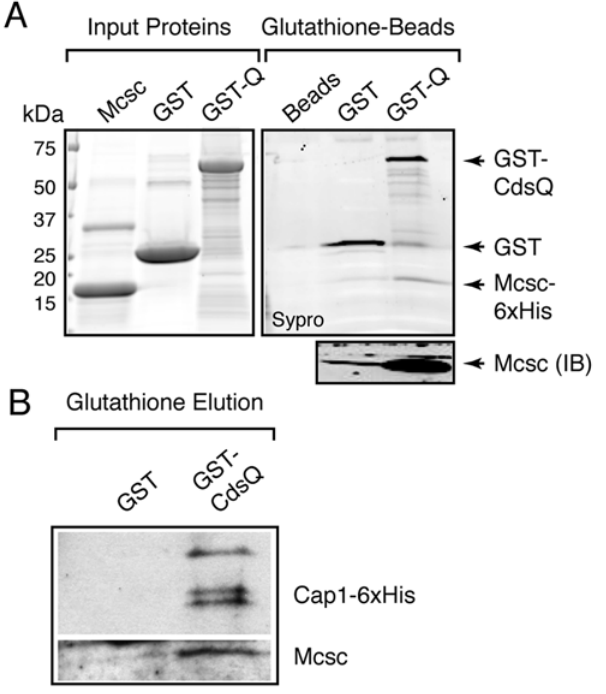
Figure 5. Mcsc-effector complexes bind to CdsQ, the C-ring component of the injectisome. (A). CdsQ binds to Mcsc . Recombi- nant GST or GST-CdsQ coupled to glutathione Sepharose beads was incubated with 6xHis-tagged Mcsc dimers. Bound proteins were eluted with 5 mM reduced glutathione and analyzed by SDS PAGE followed by Sypro Orange staining and immunoblots (IB). Arrowheads mark GST- CdsQ, GST and 6xHis-Mcsc. Mcsc was preferentially co-precipitated in the presence of CdsQ. ( B ). CdsQ binds to Mcsc-Cap1 effector complexes . Pull-down assays were done as in ( A ) but using Mcsc/Cap1-6xHis protein complexes purified by gel filtration chromatography (Fig. 3C). By immunoblot analysis, Mcsc/Cap1 protein complex co-purified only in the presence of GST-CdsQ.